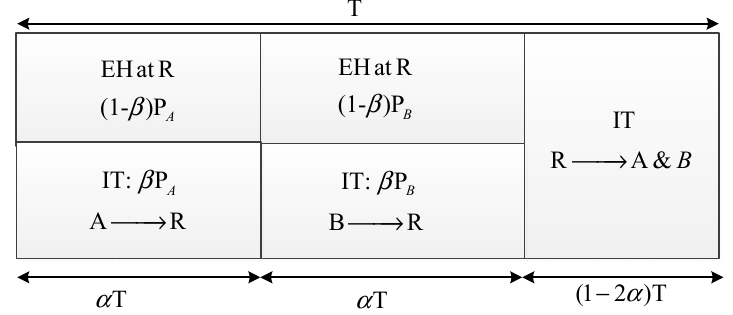
Figure 2. Energy harvesting ( EH) and information transmission (IT) phases.